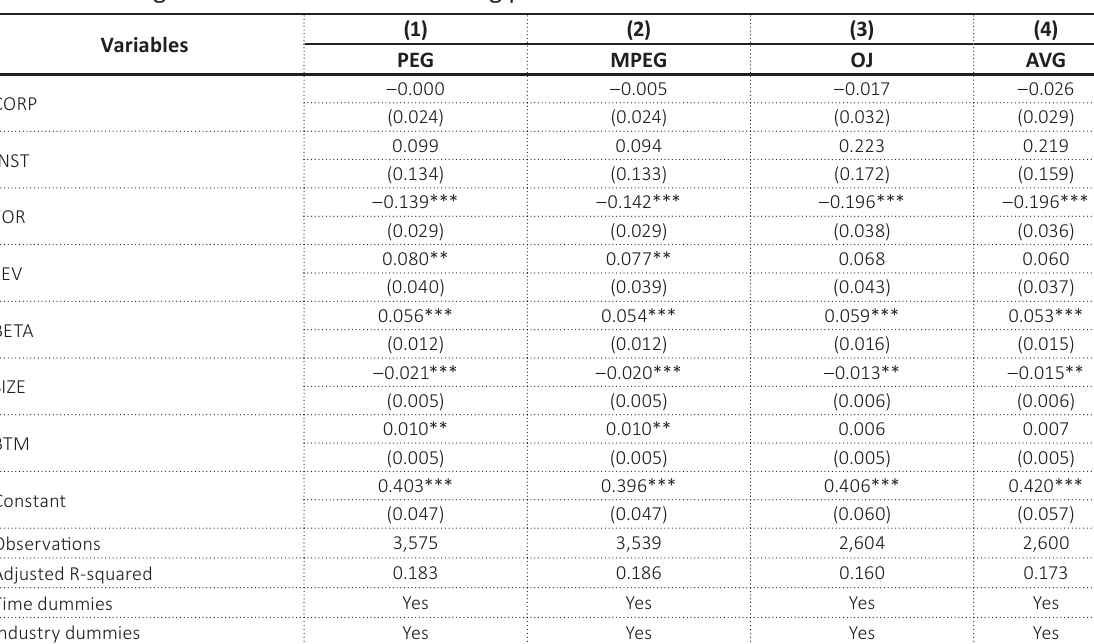
Table 1. Holding variables on ICC models using pooled OLS